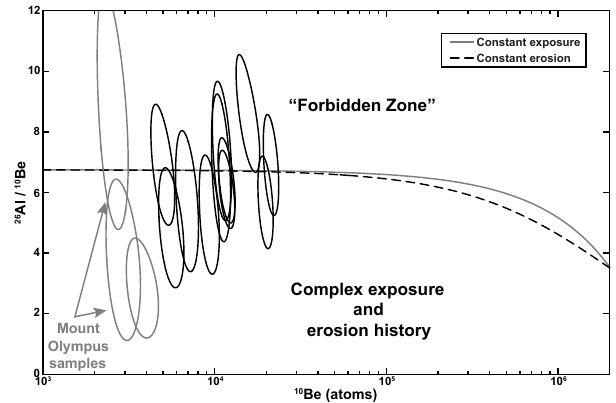
Figure 4. Erosion island plot for new Olympic Mountain samples. Each sample is represented by a 2 σ error ellipse. Grey ellipses mark samples with poor 10 Be measurements. See text for